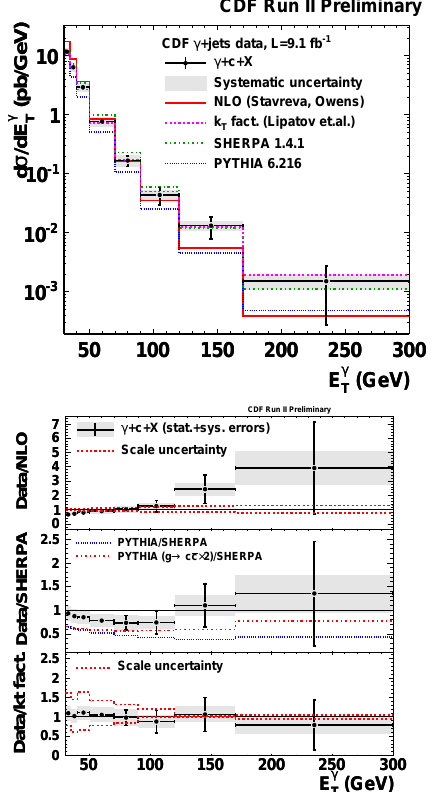
Figure 5. The measured di ff erential cross sections compared with four theoretical predictions. The absolute comparisons are shown in the left plot and the ratios of data over the theory are shown in the right plot. The shaded area around the data points indicates total systematic uncertainty of the measurement.